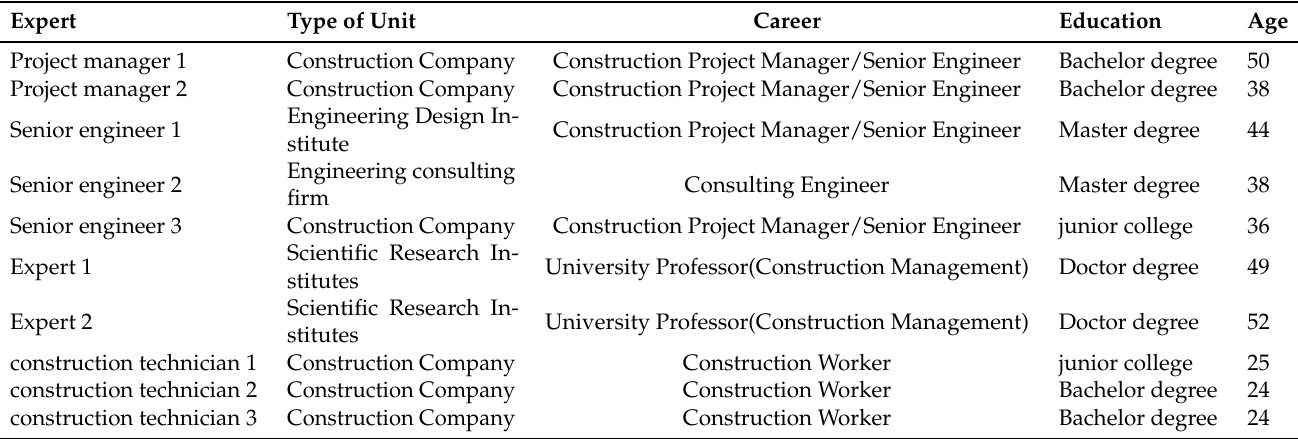
Table 1. Demographic information of the